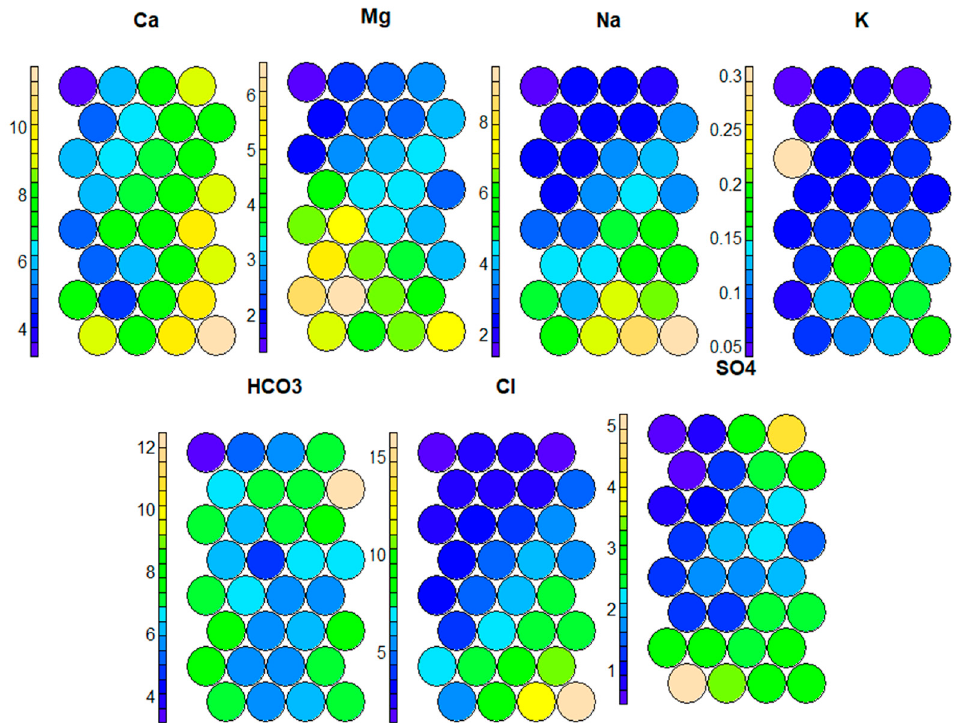
Figure 4. Heatmap of all the parameters used in the training of the SOM. In this figure, blue tones represent low concentrations while high values are of sandy shade